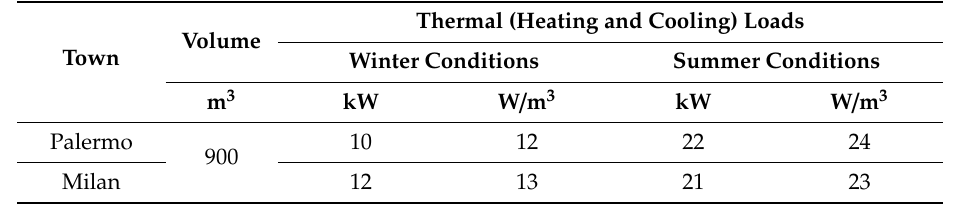
Table 4. Design thermal loads of the case study building for both heating and cooling.